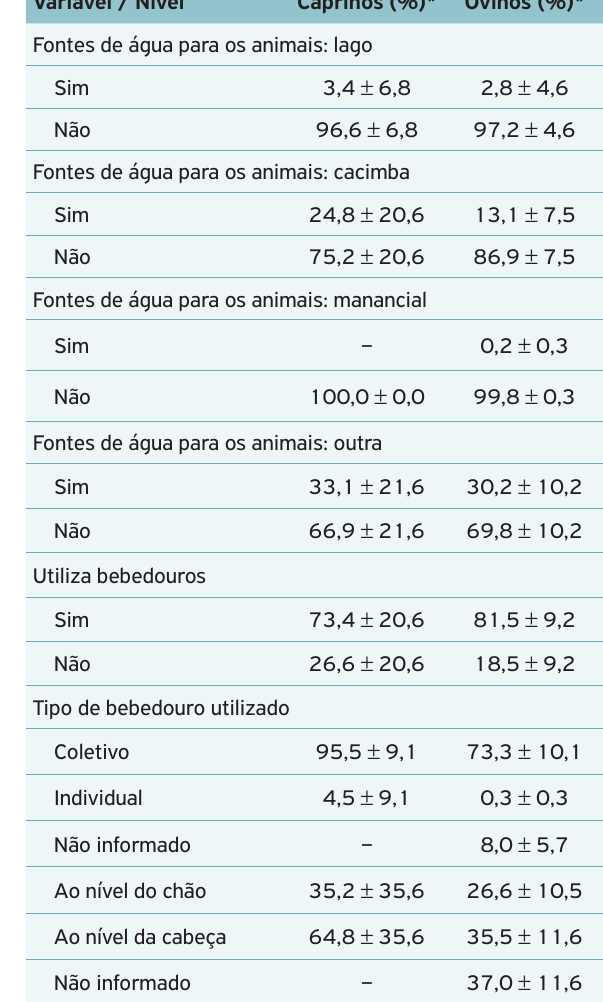
Tabela 10. Caprinocultura e ovinocultura: acesso à água, estado de São Paulo,